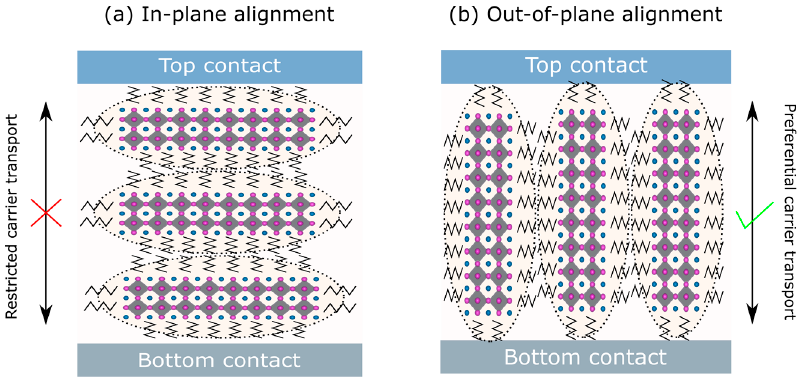
Figure 8. Solar cells based on a perovskite absorber with a two-dimensional network. ( a ) Sheets align parallel with the contacts resulting in low carrier mobility between the contacts and ( b ) sheets align perpendicular to the contacts resulting in favorable out-of-plane mobility between contacts.